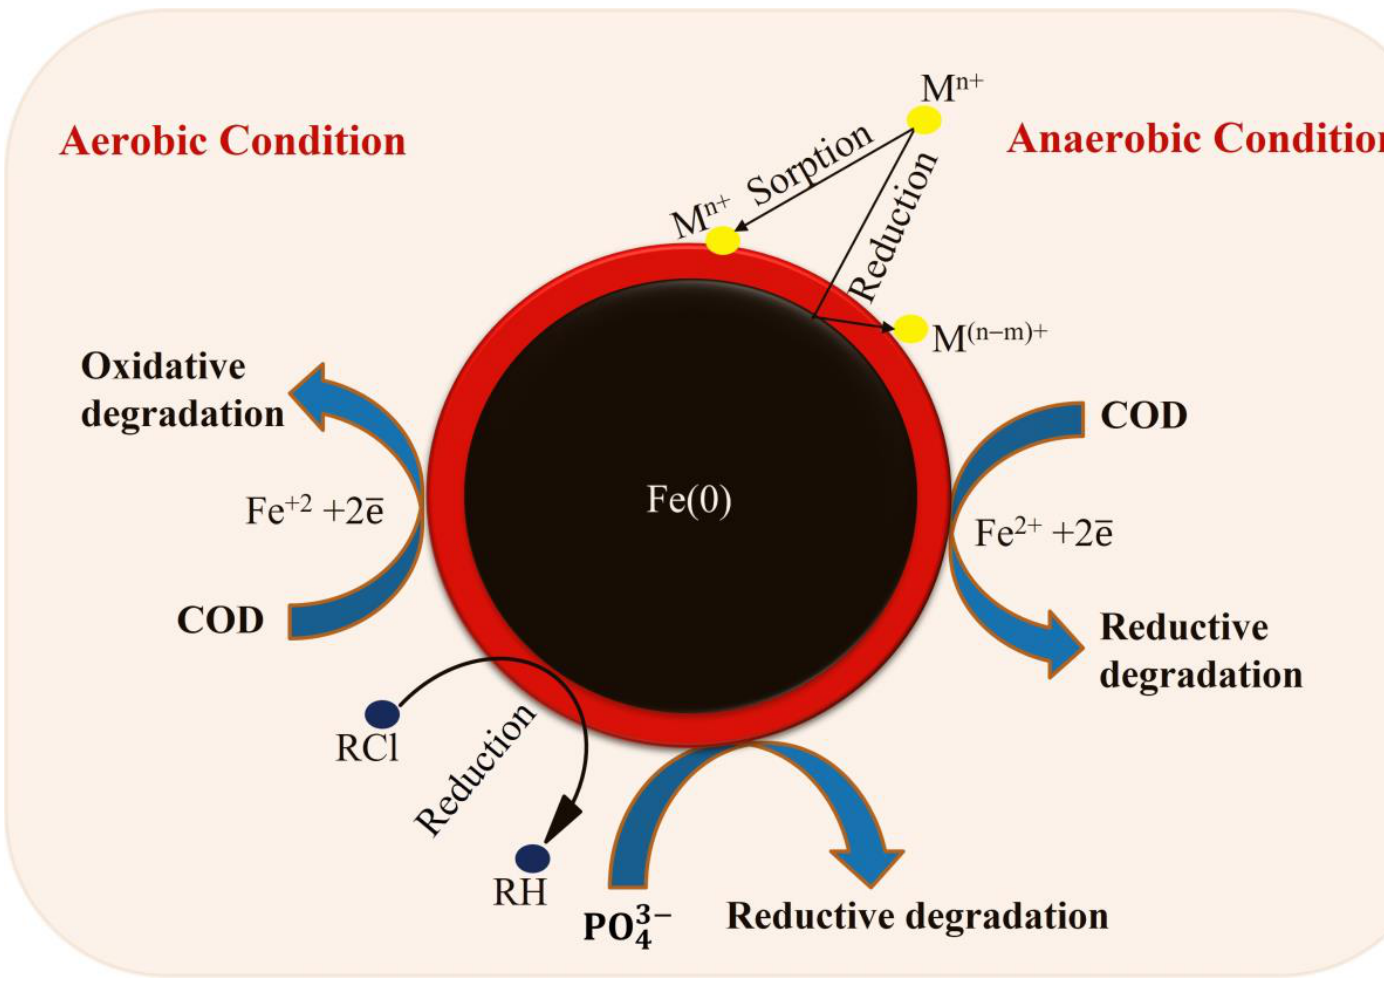
Figure 9. Schematic representation of the reaction during the treatment process of domestic wastewa- ter with nZVI